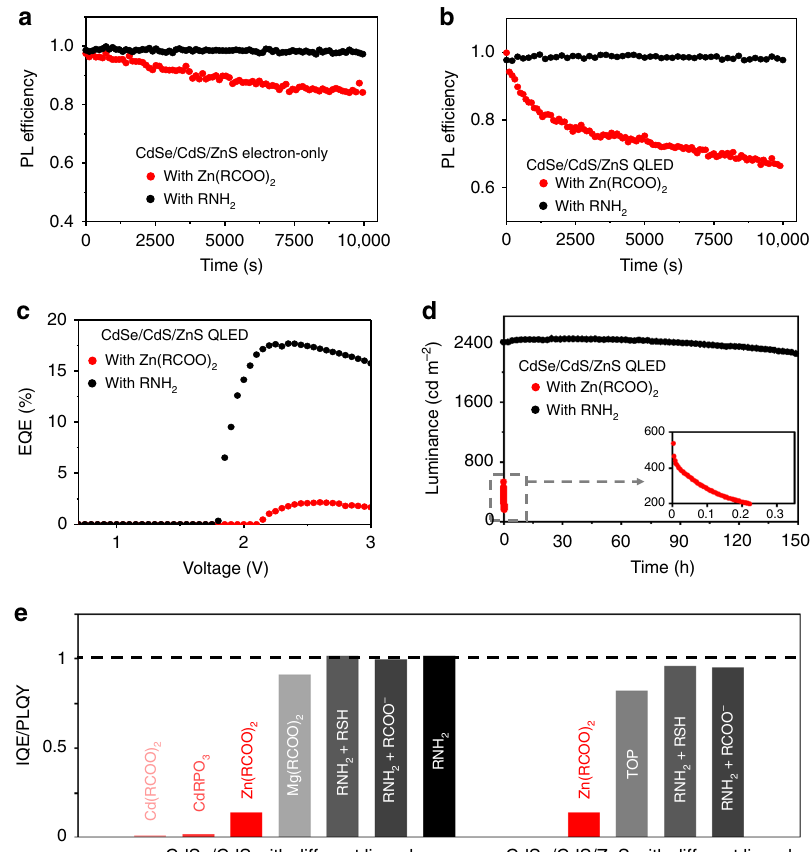
Fig. 4 Electrochemical stability and QLED performance of the red-emitting QDs with different ligands. a Relative PL ef fi ciency of the CdSe/CdS/ZnS core/shell/shell QDs in electron-only devices (ITO/TPBi (~25 nm)/QDs (~40 nm)/Zn 0.9 Mg 0.1 O (~60 nm)/Ag). Zn-carboxylate ligands are less reactive than Cd-carboxylate ones, and thus a constant current density of 100 mA cm − 2 is applied for the electron-only devices, instead of 10 mA cm − 2 used for the devices with the CdSe/CdS-Cd(RCOO) 2 QDs. Inset, the relative PL ef fi ciency of the QDs in hole-only devices (ITO/PEDOT:PSS (~35 nm)/poly-TPD (~30 nm)/PVK (~5 nm)/QDs (~40 nm)/CBP (~25 nm)/MoO x /Au) driven at a constant current density of 30 mA cm − 2 , sharing the same coordinate axes with the main plot. b , Relative PL ef fi ciency of the CdSe/CdS/ZnS core/shell/shell QDs in QLEDs driven at a constant current density of 100 mA cm − 2 . c EQE vs. driving voltage characteristics and d , Stability data of the QLEDs based on the CdSe/CdS/ZnS core/shell/shell QDs driven at the constant- current mode. e The IQE/PL QY ratio (IQE of the QLED divided by PL QY of the QD fi lm) for the CdSe/CdS core/shell and the CdSe/CdS/ZnS core/shell/ shell QDs with different